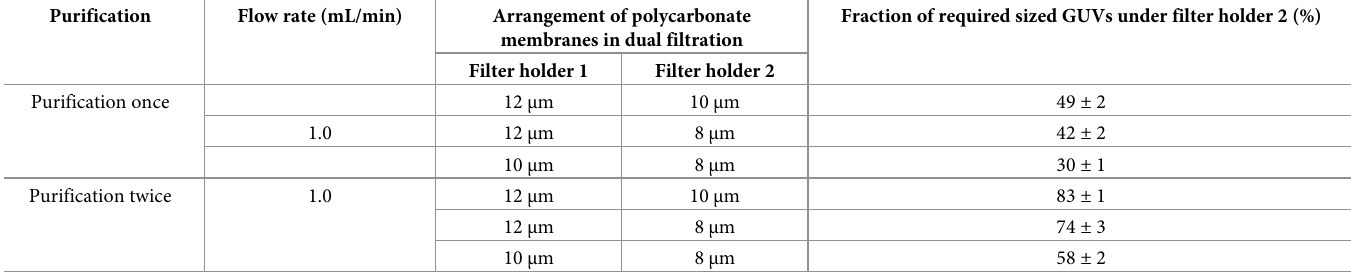
Table 2. Fraction of required sized GUVs under filter holder 2 compared to the total number of GUVs before filtration for different combination of polycarbonate membranes.